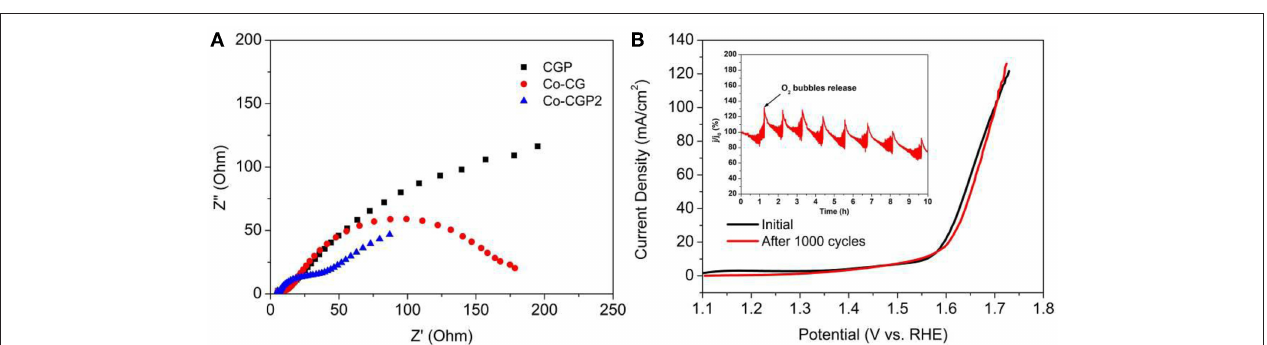
FIGURE 6 | (A) Nyquist plots and (B) LSV curves before and after 1000 cycles (inset: current retention–time curve).